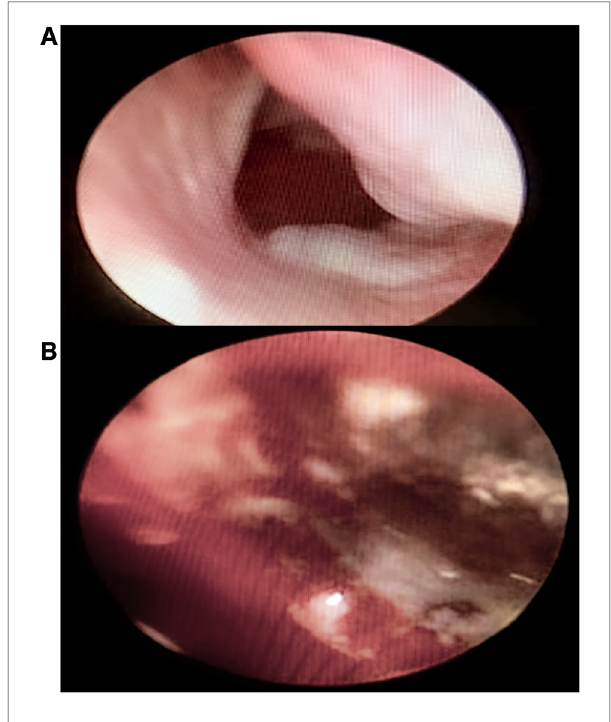
FIGURE 1 Clinical images of endoscopic appearances of pediatric invasive fungal rhinosinusitis. Typical fi ndings on endoscopy are pale/greyish nasal mucosa ( A ) and bloody crusts ( B